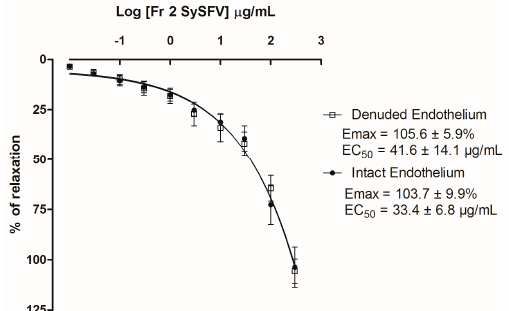
Figure 5 . Concentration–response curves showing the relaxant effect induced by Fr 2 SySFV (0.01– 1000 µg/mL) in rat mesenteric artery rings pre-contracted with phenylephrine (10 µM) in presence ( ) and absence ( ) of functional endothelium. Results are expressed as mean ± SEM; n = 7 for rings with intact endothelium and n = 8 for rings with denuded endothelium.